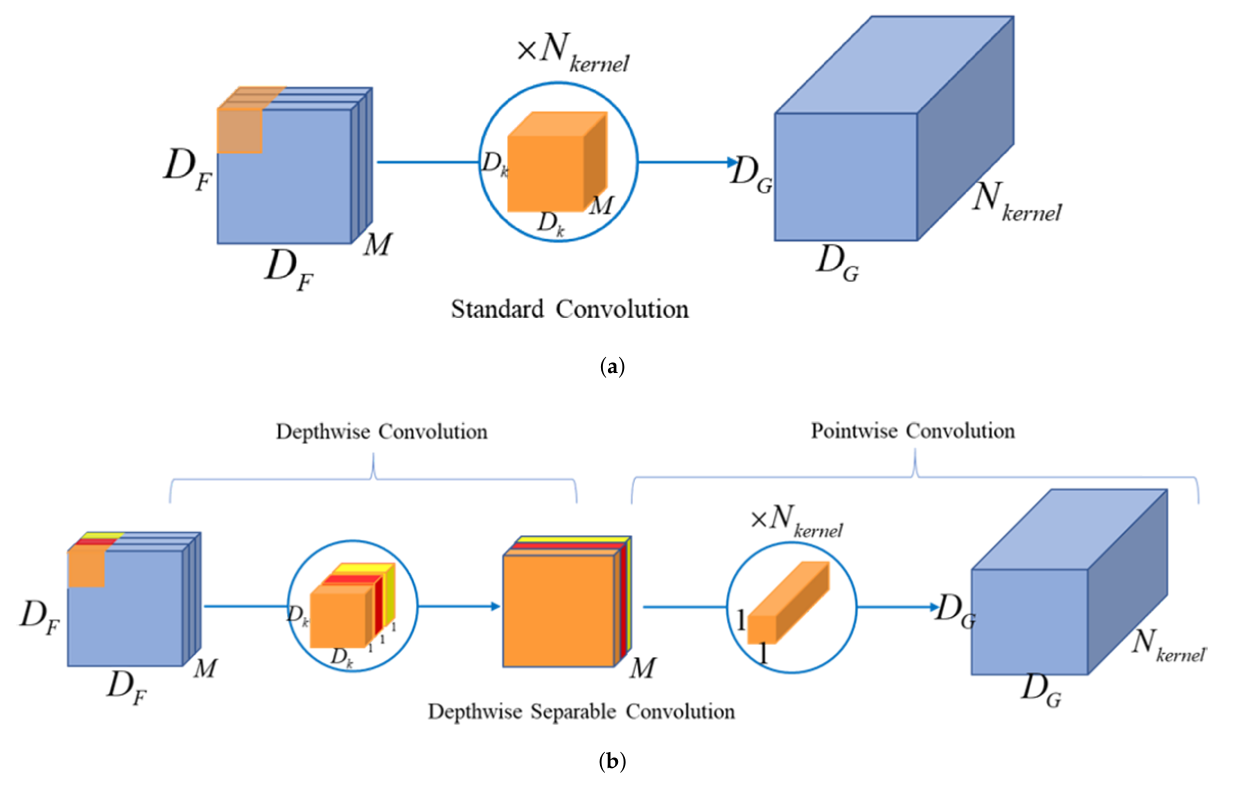
Figure 1. The structure comparison of depthwise separable convolution and standard convolution: ( a ) structure of standard convolution ( b ) structure of depthwise separable convolution( It is assumed that the output feature map has the same spatial dimensions as the input and both feature maps are